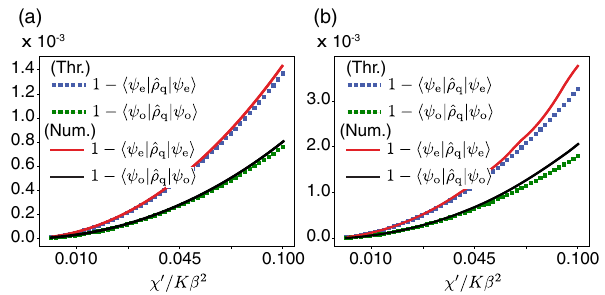
FIG. 17. Dependence of phase diffusion in the state of the storage cat as a function of the coupling strength. In (a), the time dependence of the interaction between the storage and PCO is ffiffiffi p χ ð t Þ ¼ ð χ π Þ exp ð − t 2 =T 2 p Þ with cutoffs at (cid:3) 3 T p . In (b), the 0 = time dependence of the interaction is χ ð t Þ ¼ 0 . 5 χ 0 π sin ð π t=T with cutoffs at 0 and T . χ 0 is the peak interaction strength so that ffiffiffi p p π in (a) χ 0 ¼ χ 0 and in (b) χ 0 ¼ πχ 0 = 2 . The parameters are P ¼ 4 K ( β ¼ 2 ) and T π = 4 χ β . The phase diffusion is suppressed 0 p ¼ when the excitations out of the C subspace are negligible, that is, when χ = 0 K β 2 is small. Both theoretical (dotted lines) and numerical (solid lines) results are shown. The agreement between the two is good for small χ 0 and when the adiabatic approximation is valid. Again, we find that for small χ 0 the average phase diffusion decreases quadratically with χ 0 =K β 2 . For example, in (a), the phase diffusion is < 10 − 4 when χ 0 =K β 2 < 0 . 02